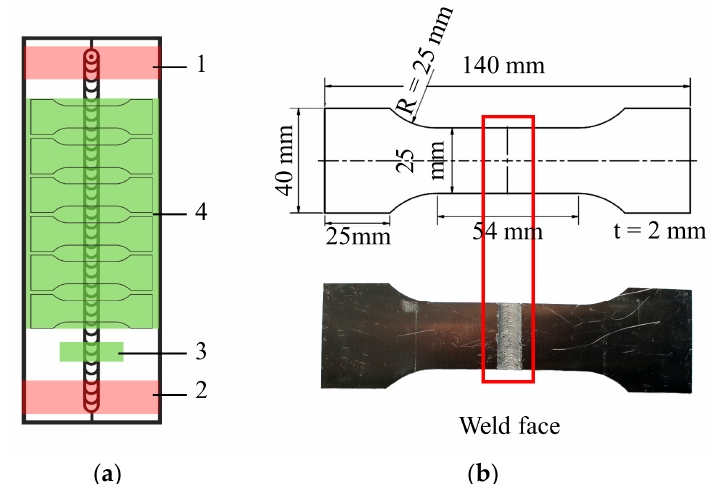
Figure 5. ( a ) Position of the milled specimens from the friction stir welded (FSW) aluminum sheets and ( b ) specimen geometry.